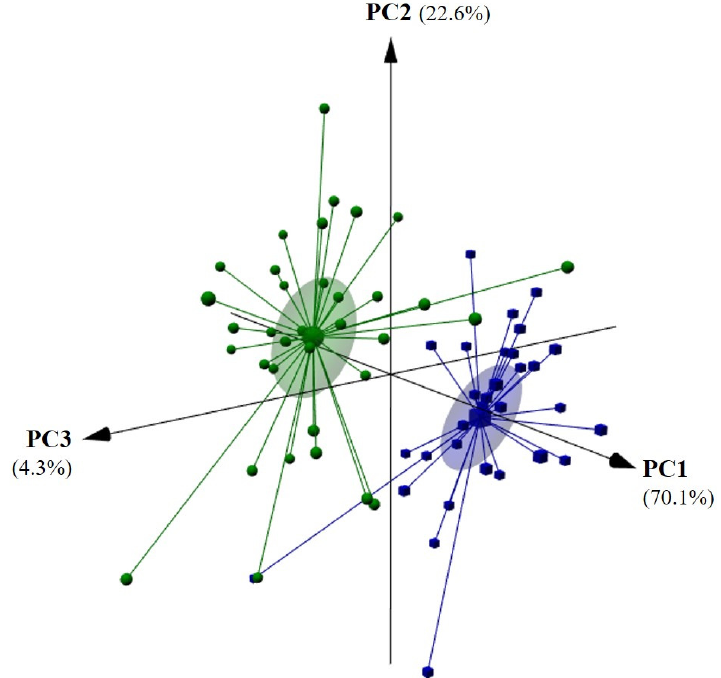
Figure 4. Unsupervised pattern recognition of olive oils by geographical origin (Côa Valley: ● , and, Douro Valley: ■ ) based on the principal component analysis (3D plot of the first three PCs) based on the mean resistance signals acquired by the nine E-nose-MOS sensors (S1_MEAN to S9_MEAN).